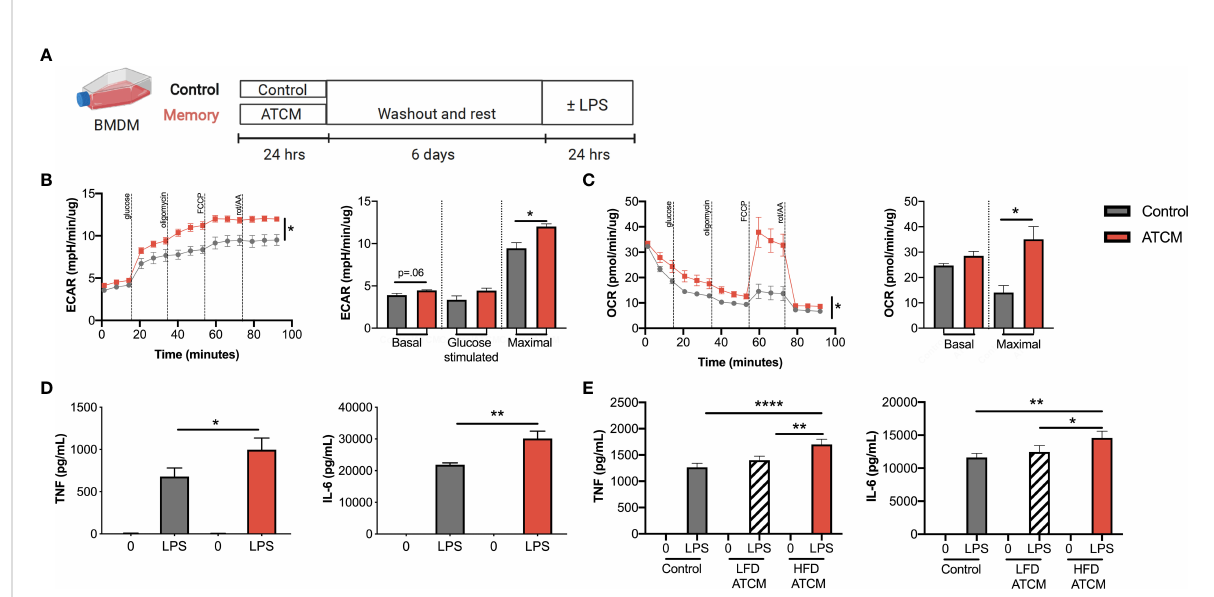
FIGURE 3 Adipose conditioned media increases cell metabolism and in fl ammation in macrophages and DCs in culture. (A) Schematic of innate immune memory in vitro models using bone marrow derived macrophages and adipose tissue conditioned media (ATCM) or control media. (B) Extracellular acidi fi cation rate (ECAR) and (C) oxygen consumption rate (OCR) during modi fi ed mitochondrial stress test by Seahorse metabolic analyzer. (D) TNF and IL-6 production induced by 100 ng/mL LPS as measured by ELISA. Data are normalized by protein concentration. (E) BMDM were treated with ATCM from mice on a high fat diet as in B-D or low fat diet and compared against control media. TNF and IL-6 production were measured by ELISA after 100 ng/ mL LPS activation. Data are means ± SEM of 3-4 populations, representative of 2-3 independent experiments. * p < 0.05, ** p <.01, **** p <